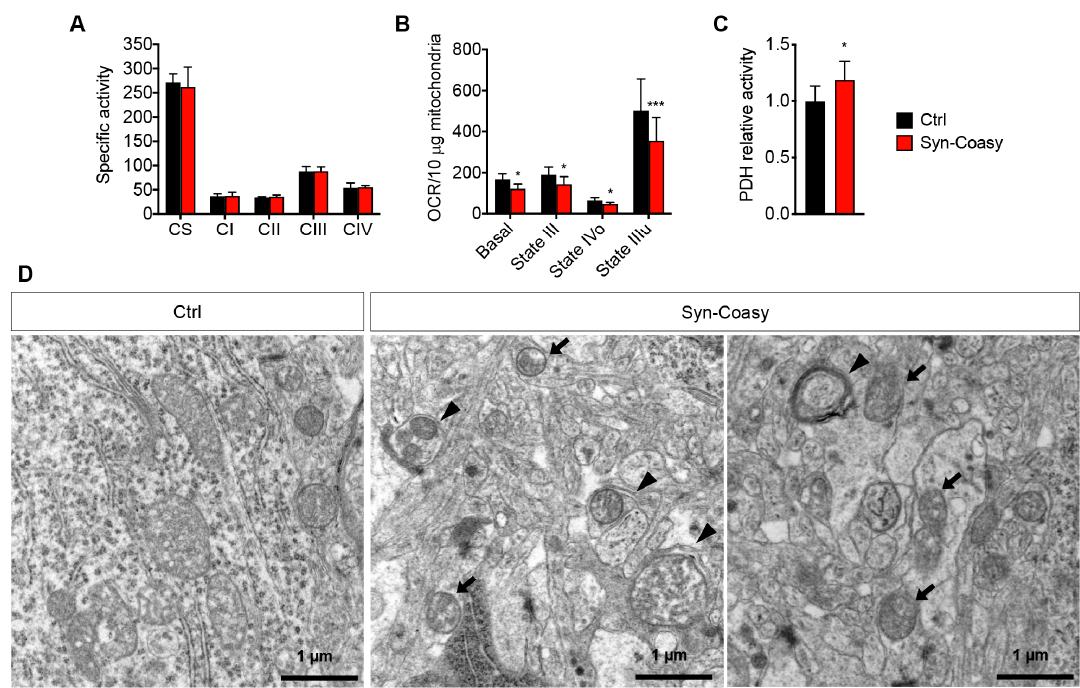
Figure 6. Mitochondrial functions. ( A ) MRC activities in forebrain from Ctrl ( n = 8) and Syn-Coasy ( n = 8), expressed as nmoles/min/mg of proteins. CS, citrate synthase; CI-IV, MRC complexes I-IV. No statistically significant differences were observed (one-way ANOVA). ( B ) Pyruvate/malate-dependent oxygen consumption rate (OCR) measured in isolated mitochondria from the Ctrl ( n = 3) and Syn-Coasy ( n = 3) forebrain under basal conditions, and after sequential addition of ADP (State III), oligomycin (State IVo), and FCCP (State IIIu). * p < 0.05; *** p < 0.001 (one-way ANOVA). ( C ) PDH relative activity in the forebrain from Ctrl ( n = 10) and Syn-Coasy ( n = 10). * p < 0.05 (one-way ANOVA). For all charts, mean ± SD is shown. ( D ) Electron microscopy of the forebrain showing altered mitochondria (arrows) and autophagosomes (arrowheads) in Syn-Coasy mice.